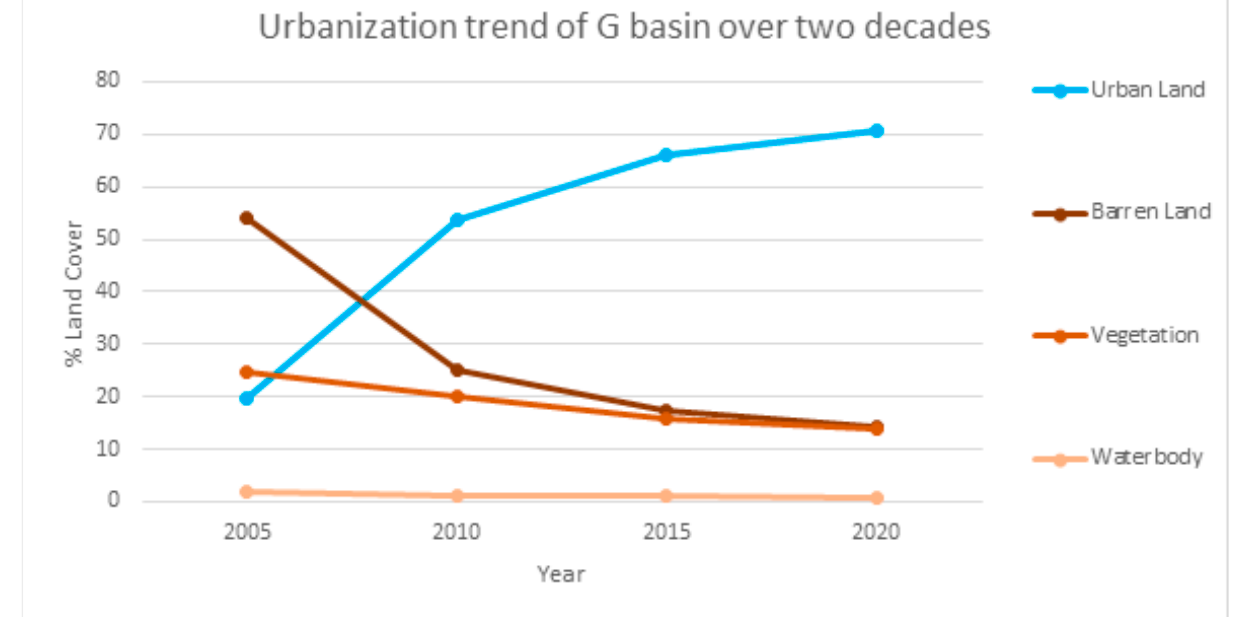
Figure 4. Urbanization trend of G-basin over two decades.